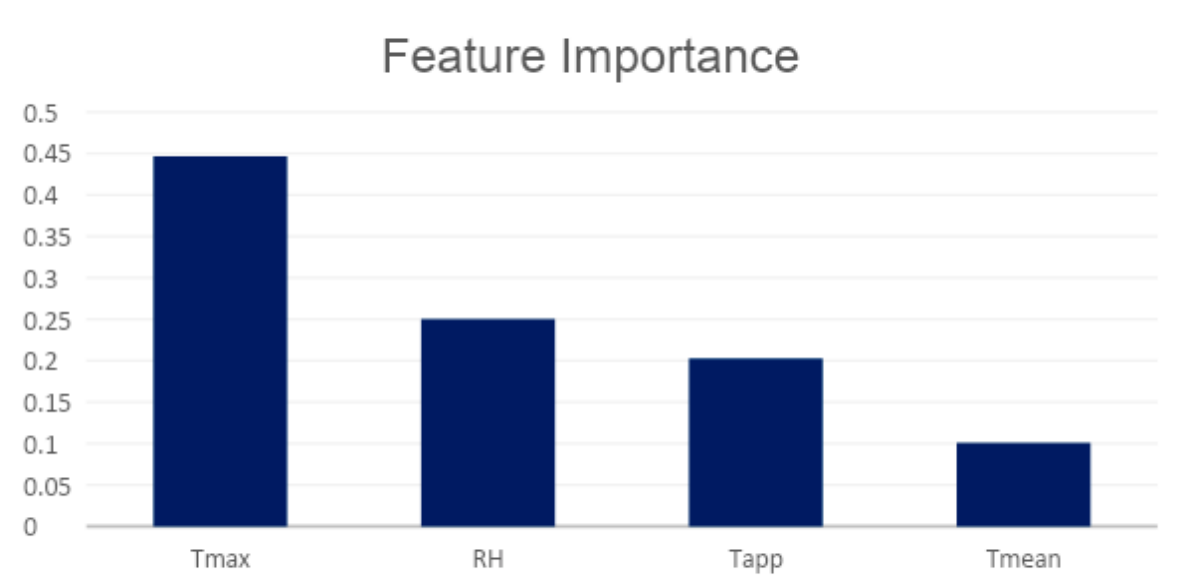
10 of 17 Table 8. Correlation between meteorological parameters and CVD admissions, with absolute value of Pearson’s coefficient (|r|) before (CVD 1 ) and after (CVD 2 ) decomposition model application. Variable